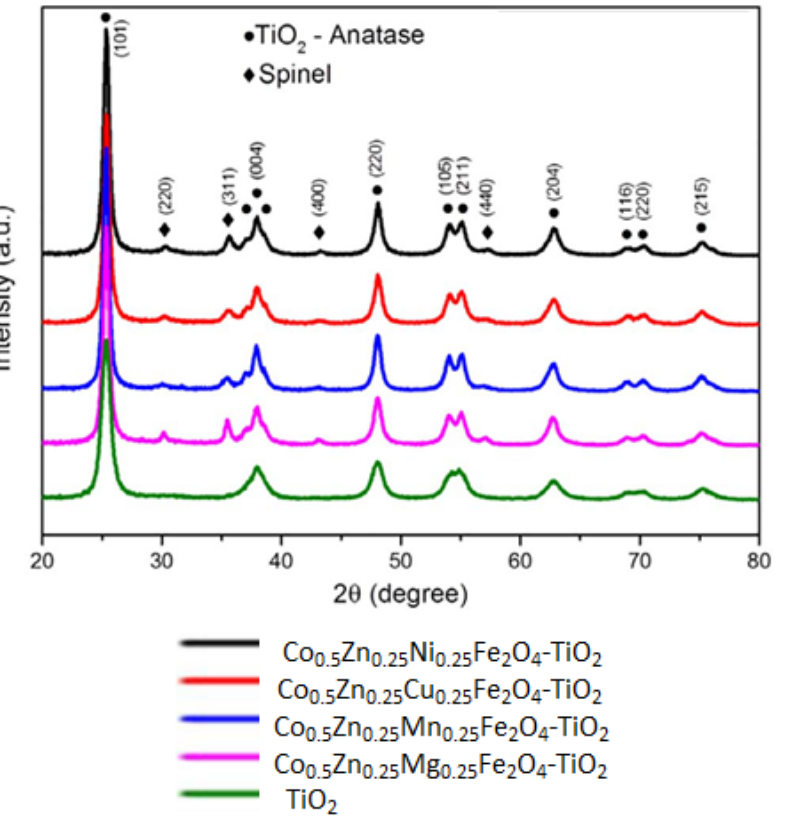
Figure 12. XRD pattern of TiO 2 and magnetic ferrite-based TiO 2 nanocomposites [117]. Republished with permission from Elsevier.